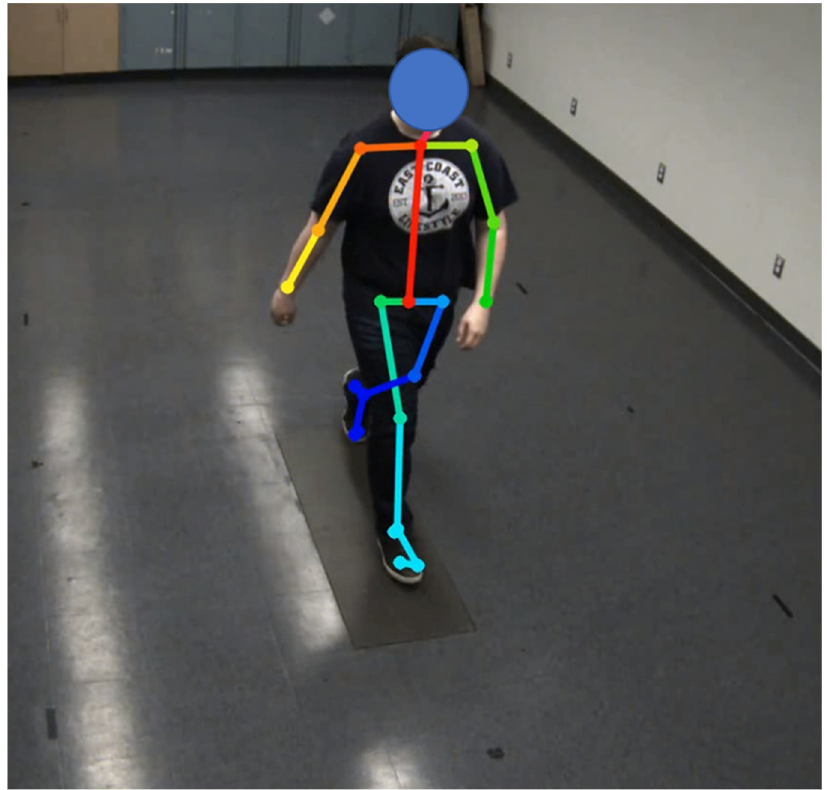
Figure 4 . Output 2D keypoints from OpenPose BODY25 of participant walking through the capture volume.